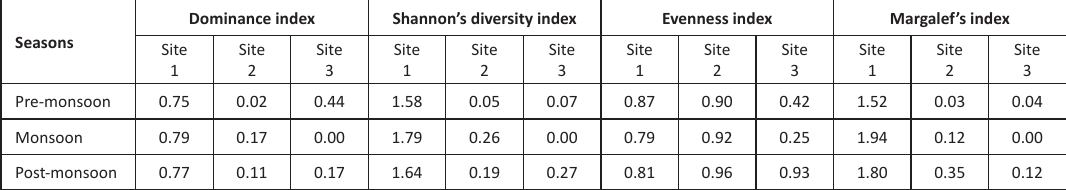
Table 5. Taxonomic indices of benthic macroinvertebrate community in river Ichamati Seasons